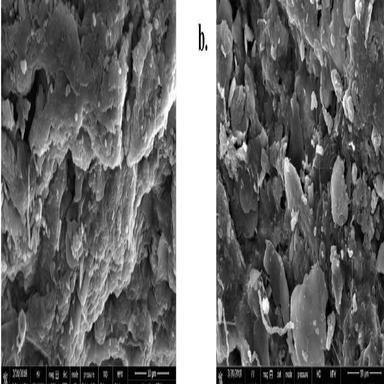
Scanning electron microscopy (4000x) of a. Pre-composted waste mixture and; b. Final vermicompost.